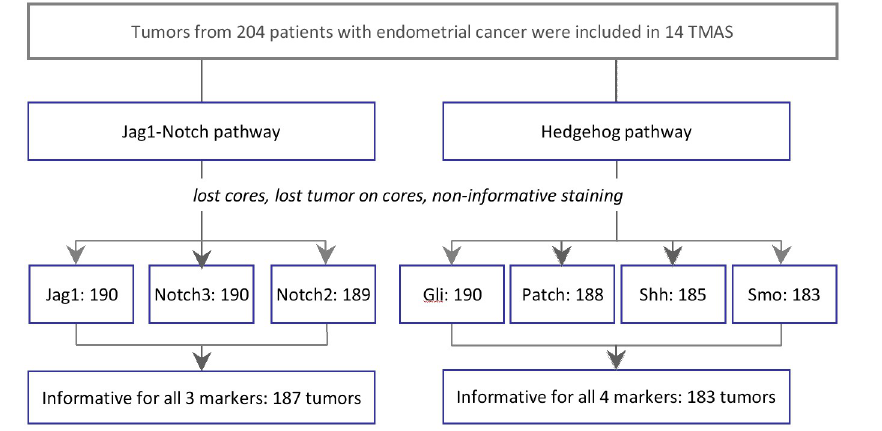
Fig 1. Study outline and informative tumors for each marker and pathway. TMA: tissue microarray.